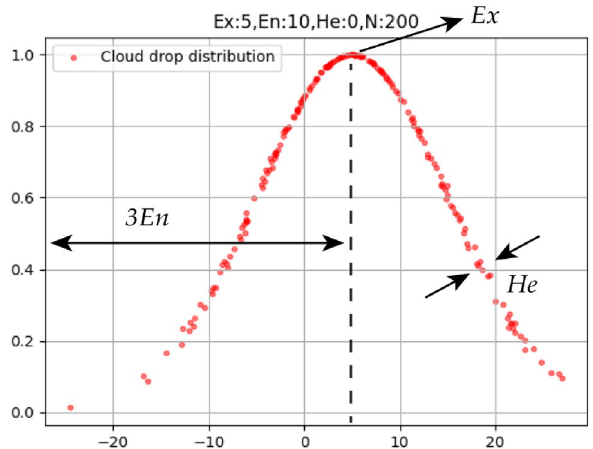
Figure 3. One-dimensional forward cloud cloud drop distribution.